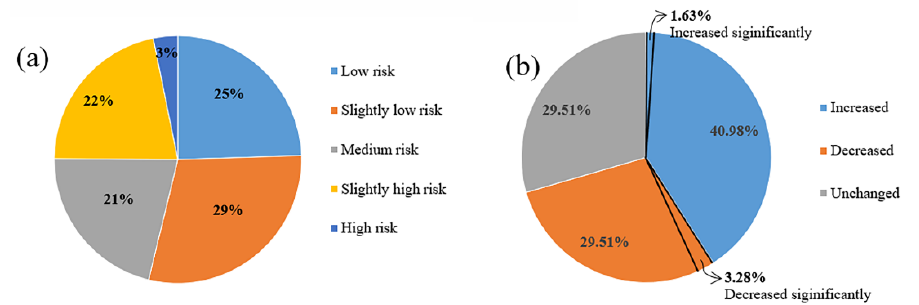
Figure 10. Proportion chart of different risk levels of combined-events risk ( a ) and increased and decreased risk ( b